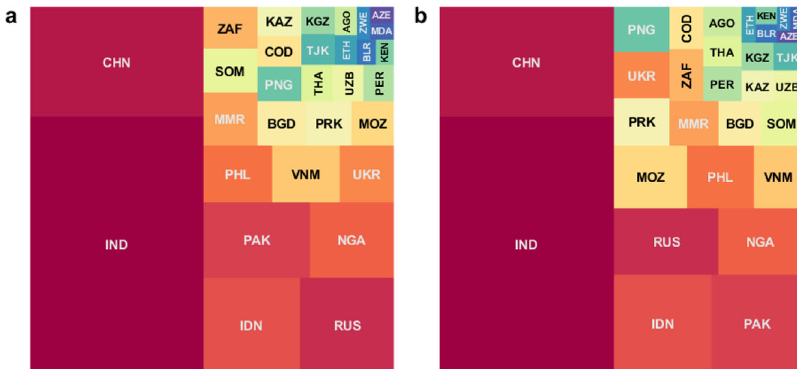
Fig. 2 Country-wise contribution to vaccine-avertable incidence of RR-TB. The area of each square is proportional to the median estimate from n = 200 posterior samples, for the absolute number of avertable rifampicin-resistant tuberculosis (RR-TB) cases by a post-exposure, M72-like vaccine, between 2020 and 2035. Panel a shows cases averted by a vaccine alone, while panel b shows cases averted by a combination of a vaccine and measures to improve the management of RR-TB (both relative to a scenario of no vaccine, and no improvement in RR-TB, i.e. status quo). Countries are denoted by their ISO alpha-3 codes and their corresponding full names are listed in Table 1. Colours for each country are only for the purpose of display, and do not designate any quantitative